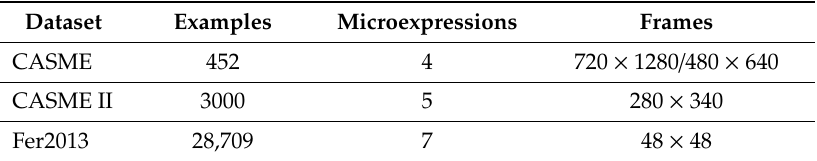
Table 2. Dataset descriptions and metadata composition.